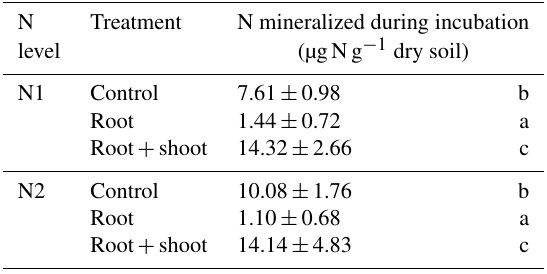
Values represent means ( n = 4 ) ± standard deviation. Different letters in the same column indicate a significant difference according to Tukey’s HSD post hoc tests at p ≤ 0 . 05 . Table 5. Significance of fixed effects of soil NO − Ng − 1 ), water-extractable organic C (WEOC, µgCg − 1 ), and first- formed) using a linear mixed-effect